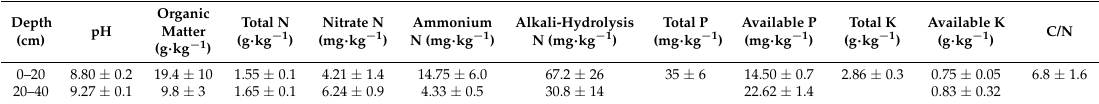
Figure 1. Phenological phase of Phragmites communis . Table 1. Soil physical chemical properties.